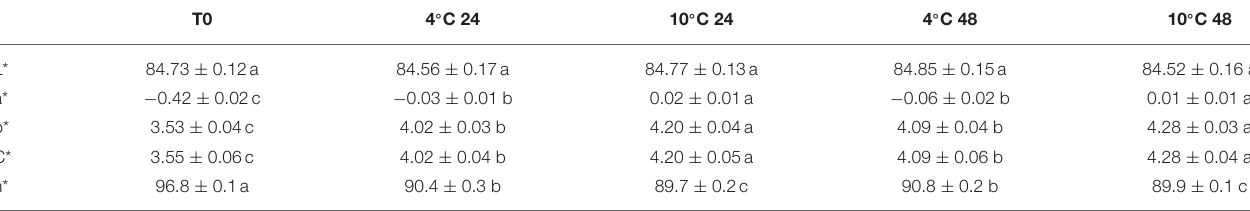
TABLE 3 | Wine CIELAB parameters (L*, a*, b*, C*, h*) at the end of the alcoholic